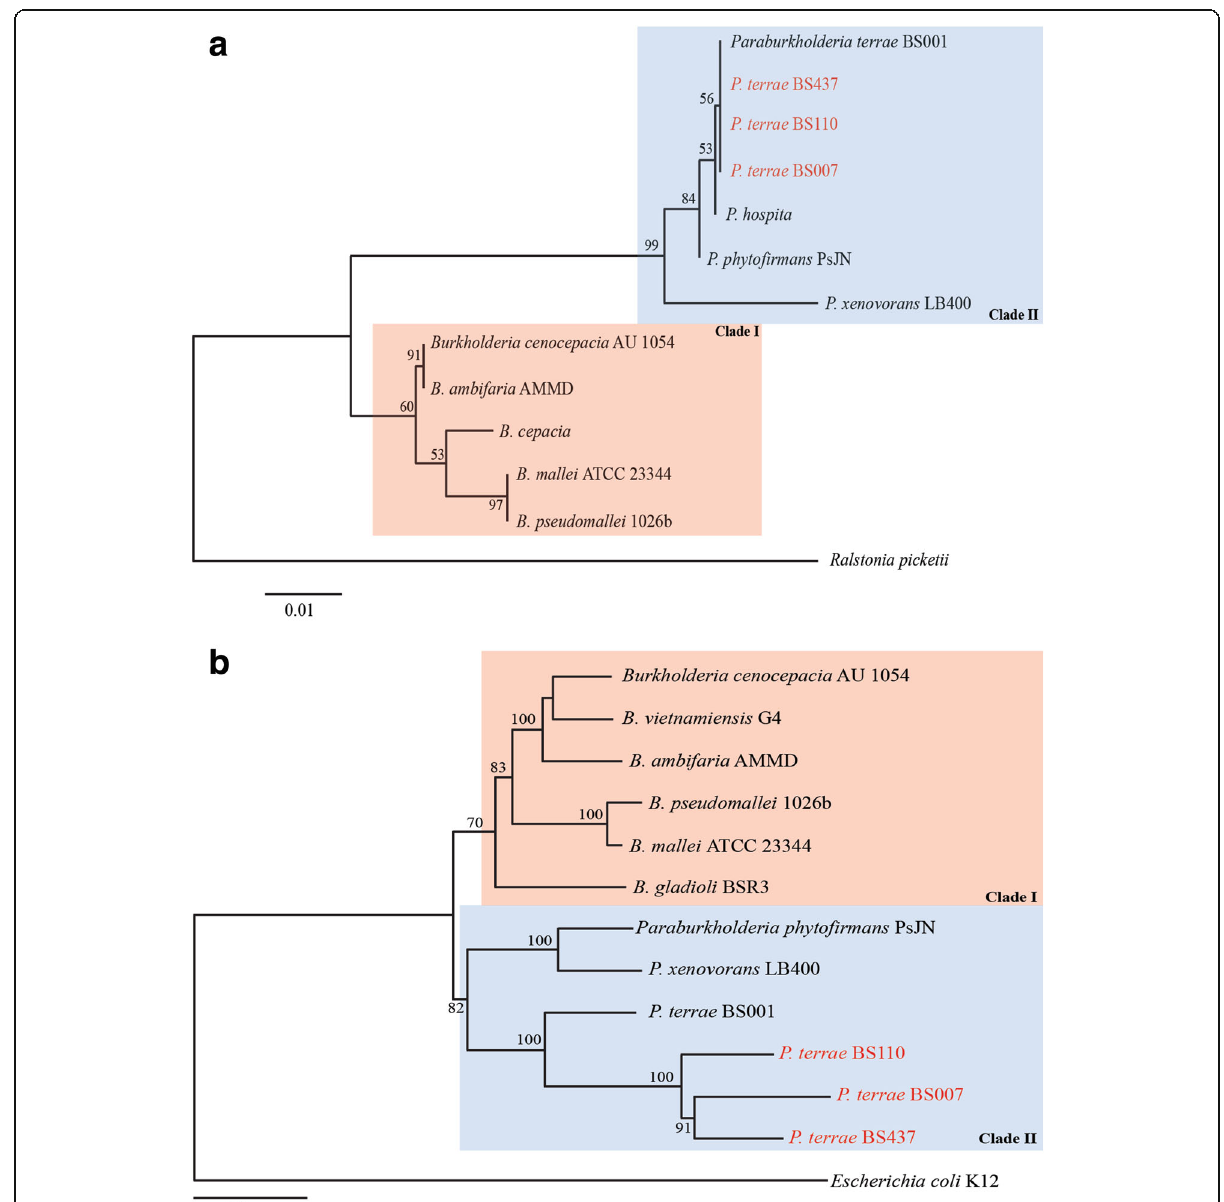
Fig. 1 Phylogenetic tree of selected Burkholderia and Paraburkholderia strains based on 16S rRNA gene sequences ( a ) and on alignment of seven concatenated core genes ( aroE, dnaE, groeL, gyrB, mutL, recA, and rpoB ) ( b ). Evolutionary distance were computed with MEGA7 using the maximum- likelihood method. The bootstrap values above 50% (from 1000 replicates) are indicated at the nodes. P. terrae strains BS007, BS110 and BS437 were all found to belong to clade II. Clade I mainly consists of pathogenic Burkholderia species, while clade II, mainly consisting of environmental strains, was assigned to the new genus Paraburkholderia . See Sawana et al .